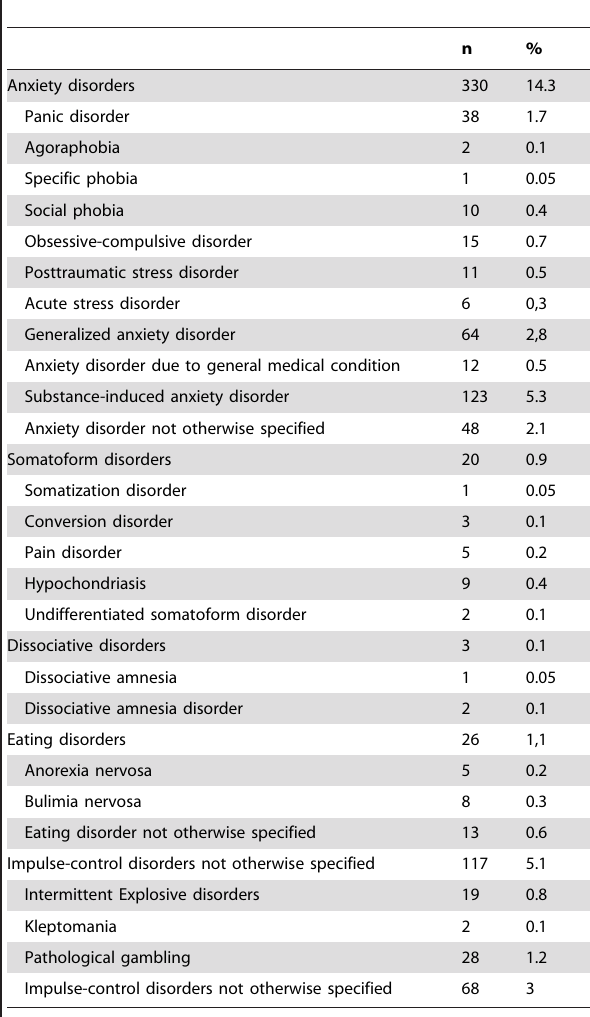
Table 3. Prevalence of anxiety, somatoform, dissociative, eating and impulse-control disorders.